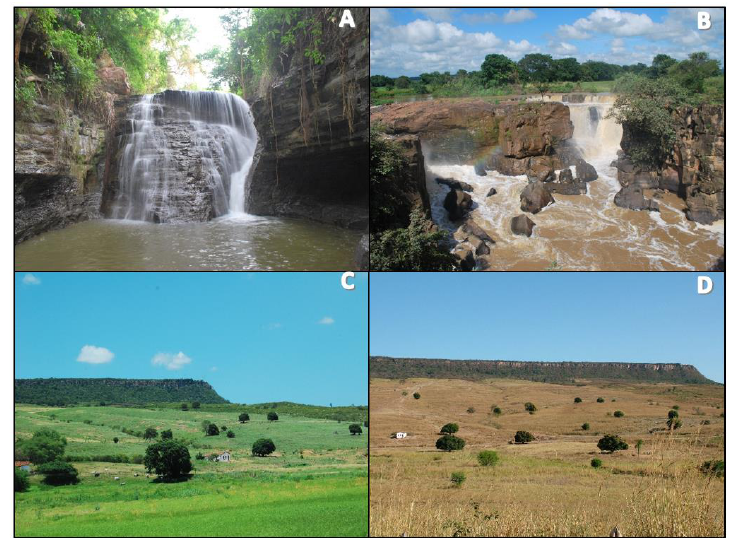
Figure 8. Water availability and climatic aspects. ( A ) — Batateiras geosite (Sítio Fundão trail), water- fall of the homonymous river. ( B ) — Missão Velha Waterfall geosite, canyon of the Salgado River. ( C ) and ( D ) — Pontal da Santa Cruz geosite, landscape differences related to the predominance of different seasons (rainy and dry); Araripe UGG. Source: Research Collection.